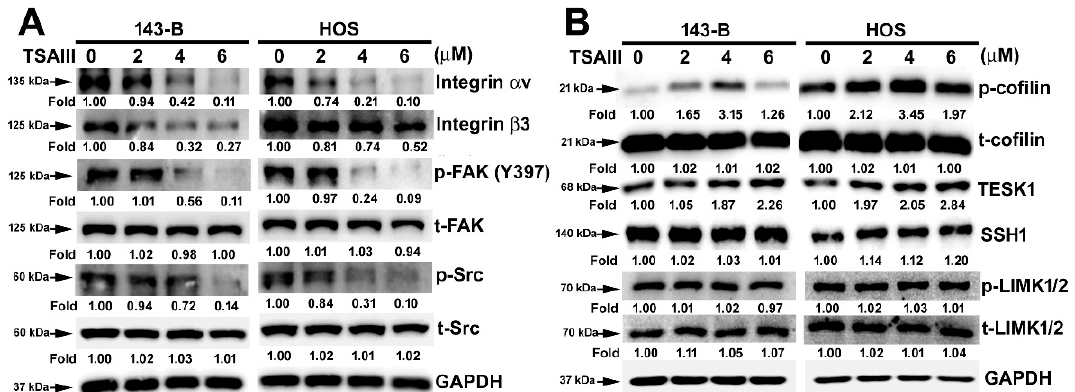
Figure 3. Regulation of TSAIII on integrin- α v, integrin- β 3, and cytoskeletal-related protein expression in human osteosar- coma cells. Human 143-B and HOS osteosarcoma cells were treated with various concentrations of timosaponin AIII (TSAIII; 0, 2, 4, and 6 μ M) and then harvested to detect the expression and activation of invasive motility-related proteins through immunoblotting. The measured invasive motility-related proteins include ( A ) integrin- α V, integrin- β 3, phospho-FAK (focal adhesion kinase) (Y397), total-FAK, phospho-Src, total-Src, ( B ) phospho-cofilin, total-cofilin, testis associated actin remodelling kinase 1 (TESK1), SSH1 (slingshot protein phosphatase 1), phospho-LIM domain kinase 1 and 2 (LIMK1/2), and total-LIMK1/2. Glyceraldehyde-3-phosphate dehydrogenase (GAPDH) was used as the internal control.